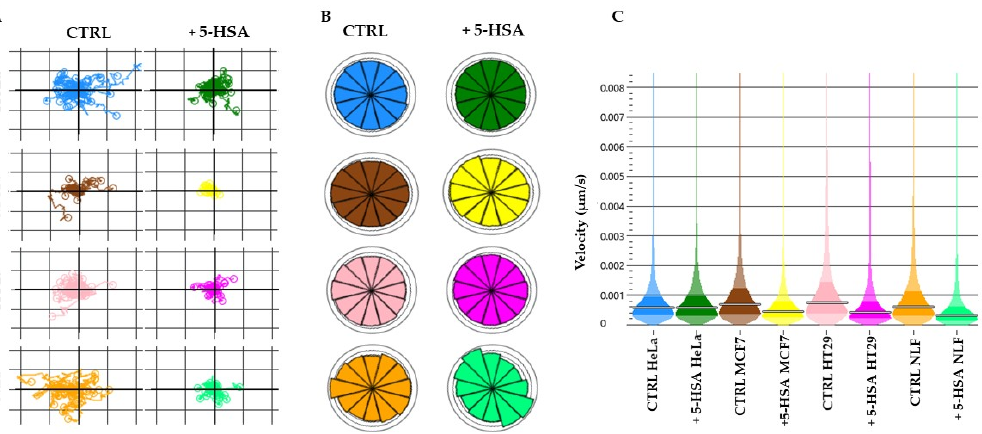
Figure 4. Analysis of cellular motility. ( A ) Average confinement ratio of HeLa, MCF7, HT29, and NLF cells over 72 h after treatment. ( B ) Directionality and ( C ) Average instantaneous velocity of HeLa, MCF7, HT29, and NLF cells over 72 h after treatment. Error bars represent the inter-quartile range.